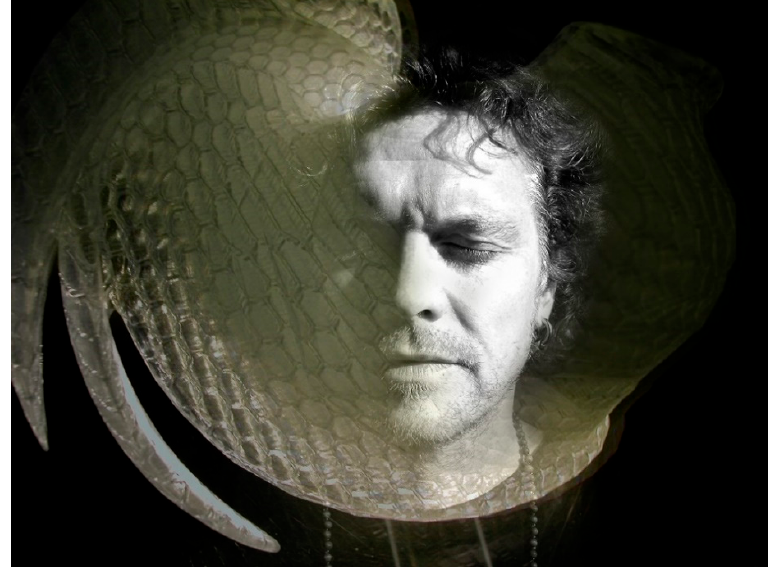
Figure 2. Still from Esomotive project with Def Leppard drummer Rick Allen in hypnotic trance. Exhibited at Susanne Vielmetter gallery 2003.